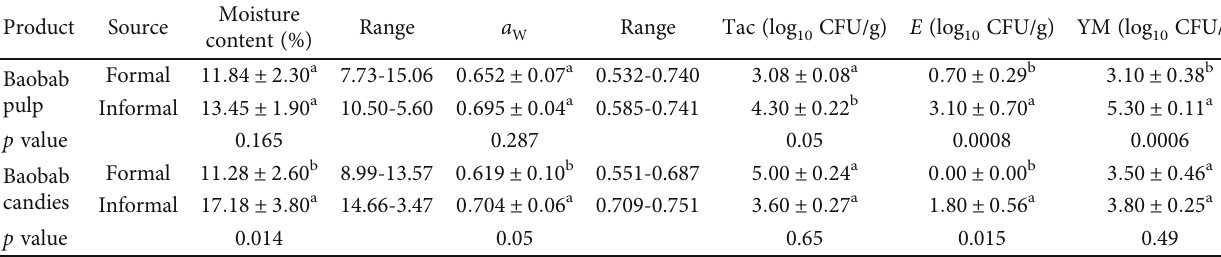
Table 1: Intrinsic properties and microbial content of baobab products from formal and informal